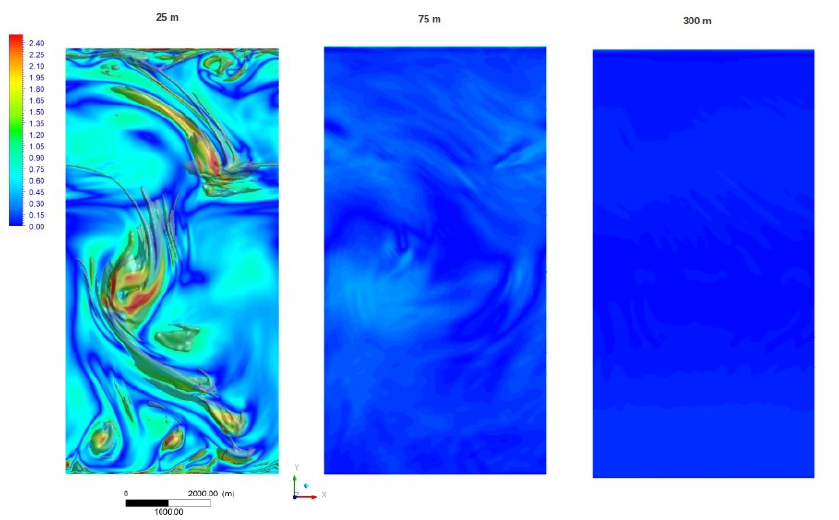
Figure 4. The velocity field at the depths of 25 m ( left ), 75 m ( middle ), and 300 m ( right ). The struc- tures in grey are the projections of the Ro = 1 isosurface.